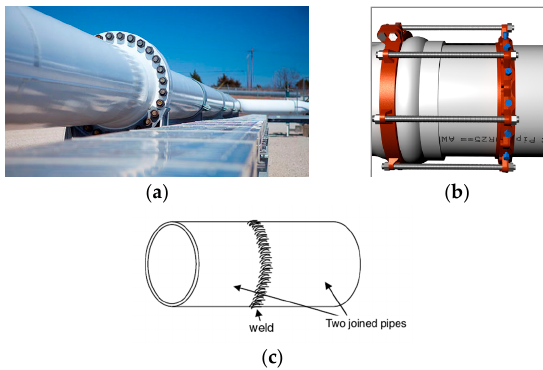
Figure 3. Pipeline joints: ( a ) flange type; ( b ) push-on type; ( c ) welding type.